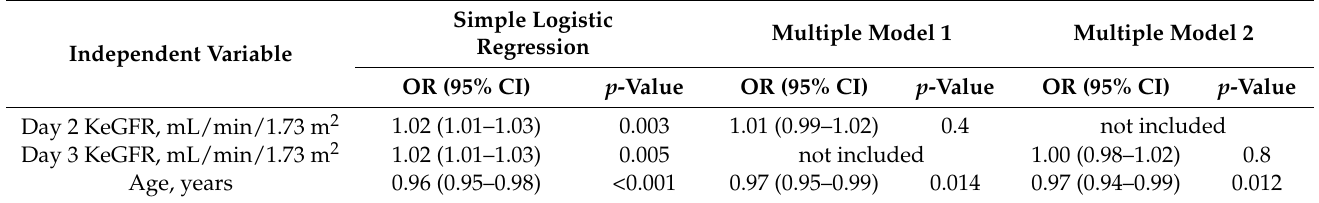
Table A2. Logistic regression models verifying the differences in KeGFR between the study centers. Study center (Wadowice vs. Sucha Beskidzka as a reference category) was used as a dependent variable. KeGFR differences between the study centers became insignificant after adjustment for